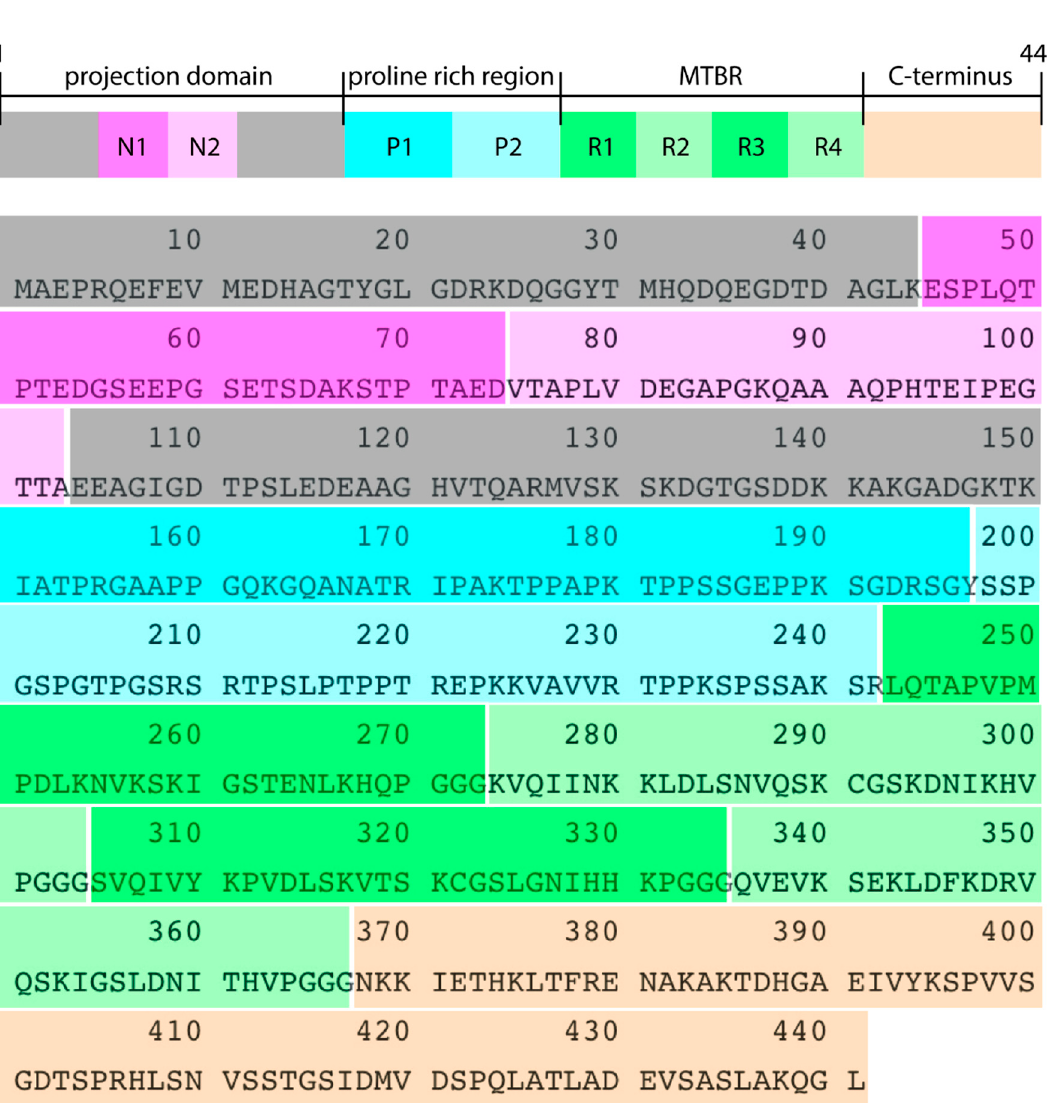
Figure 2. Primary sequence and regions of 2N4RTau isoform, comprising 441 amino acids. N1 and N2 correspond to the two N terminal inserts, P1 and P2 are the proline-rich regions, and R1 to R4 are the four imperfect repeats responsible for the binding to the microtubule.